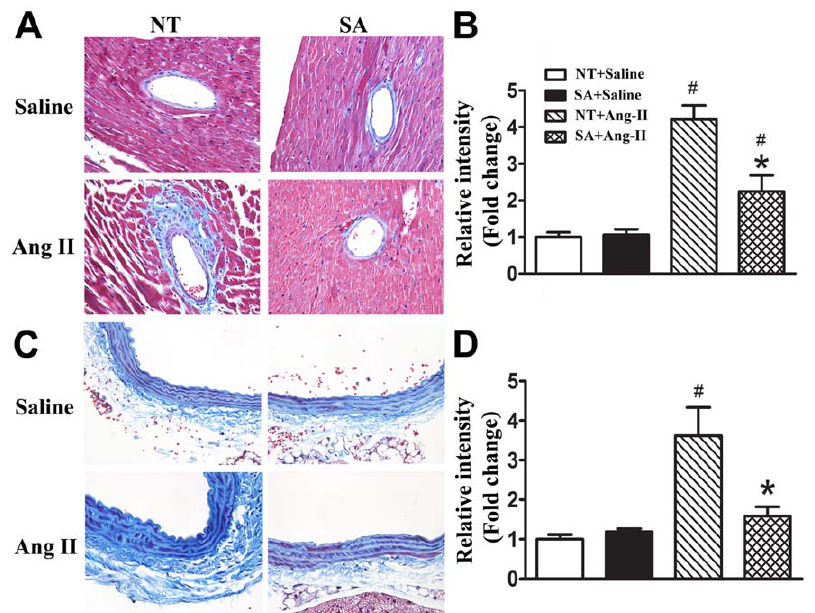
Figure 3. ACE2 over expression in the brain reduces Ang II-induced collagen deposition in aortas and coronary arteries. Mice were anesthetized and hearts were processed for Masson’s Trichrome staining at the end of 2 weeks Ang II or saline infusion. The average trichrome staining densities were quantified by using Image-Pro Plus software. Brain-targeted ACE2 over expression significantly reduces collagen deposition in coronary arteries ( A, B ) and aortas ( C, D ) following 2 weeks of Ang II infusion. N=5/group. Statistical significance: * P , 0.05 vs. NT with the same treatment; # P , 0.05 vs. saline with the same genotype.